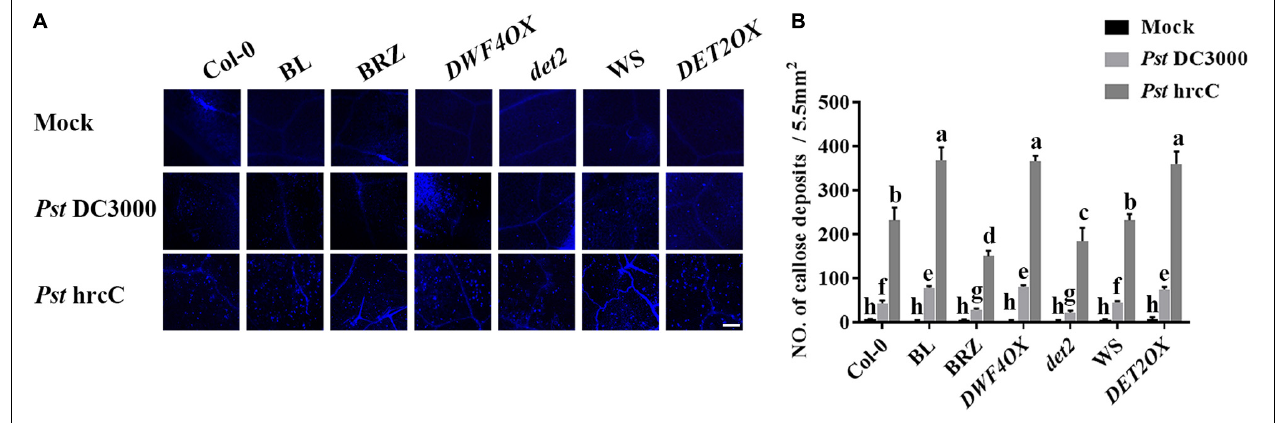
FIGURE 4 | Brassinosteroids induce callose deposition after infection. (A) Callose deposition in infected leaves at 1 dpi. Callose deposition was visualized by fluorescence microscopy. Bar, 200 µ m. (B) Number of callose deposition in the 5.5 mm 2 microscopic fields. Callose deposition was counted in 8–12 microscopic fields of 5.5 mm 2 from 8 to 12 different leaves and three biological repeats. Significant differences ( P < 0.05) are denoted by different lowercase letters.